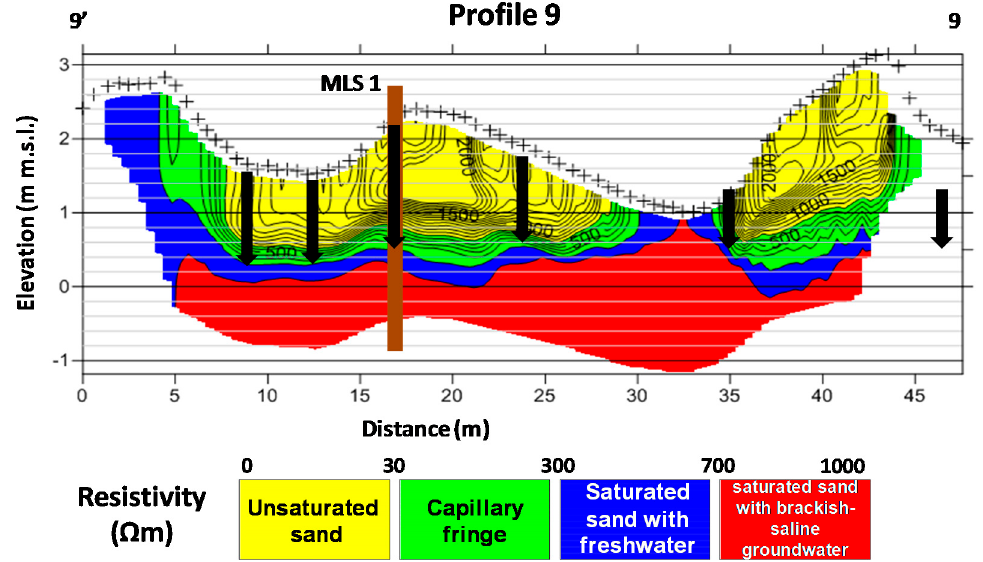
Figure 7. Subsurface model of profile 9’-9. Black arrows represent the auger holes location and the arrow head the measured WTD. In this case the electrode spacing is 0.5 m and the investigation depth is about 2–2.5 m.